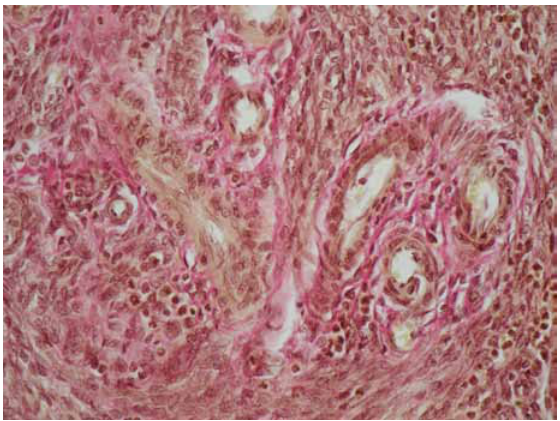
Figure 3. Photomicrography. Large-caliber vessels in the outer and inner border of the muscle layers of the myometrium. Stained by Van Gisone. Increase 400.